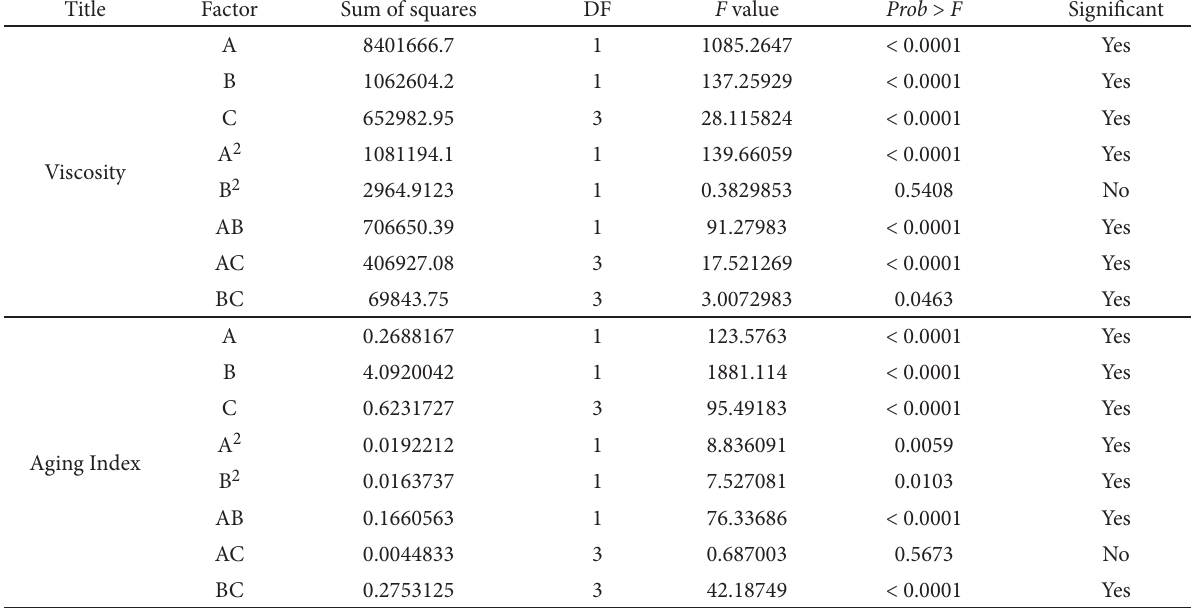
Table 3. Analysis of variance for response surface reduced quadratic model of viscosity and aging index